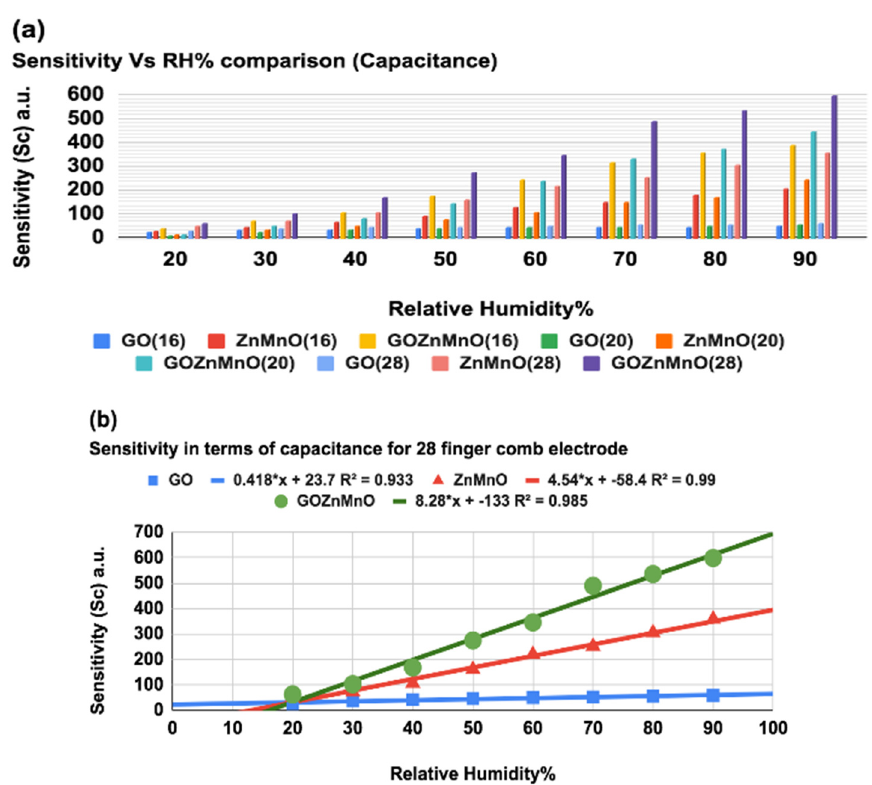
Figure 8. ( a ) Sensitivity vs. RH% comparison chart for GO-Mn x Zn 1 − x O nanocomposite, Mn x Zn 1 − x O and GO for 28-, 20-, and 16-finger comb electrodes in terms of capacitance. ( b ) Sensitivity ( S C ) as a function of RH% for 28 fingers comb electrodes with a linear fit.